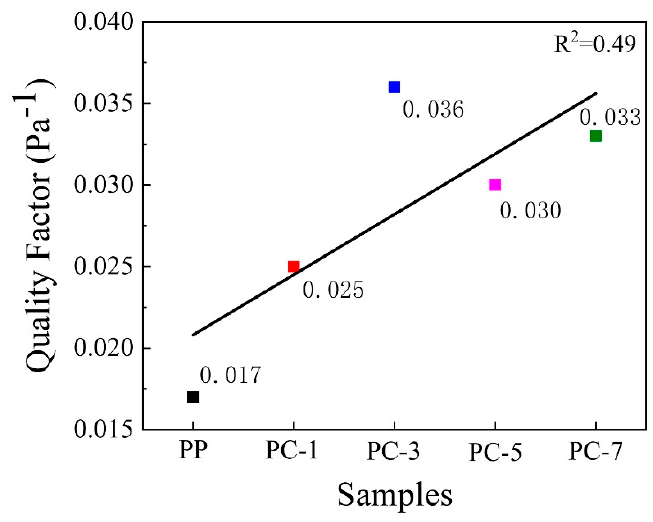
Figure 15. The quality factor of PP meltblown membranes containing di ff erent content of PC.